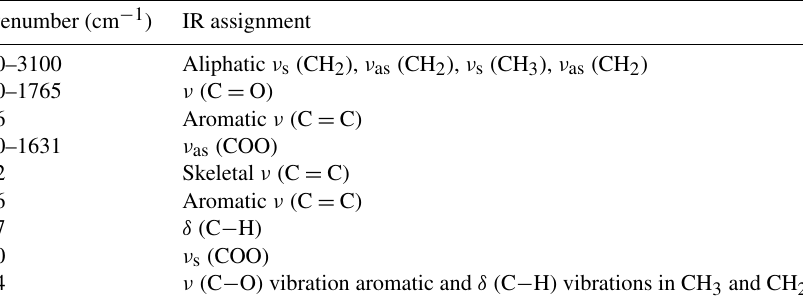
Table A2. FTIR peak assignments ∗ used for analysis of